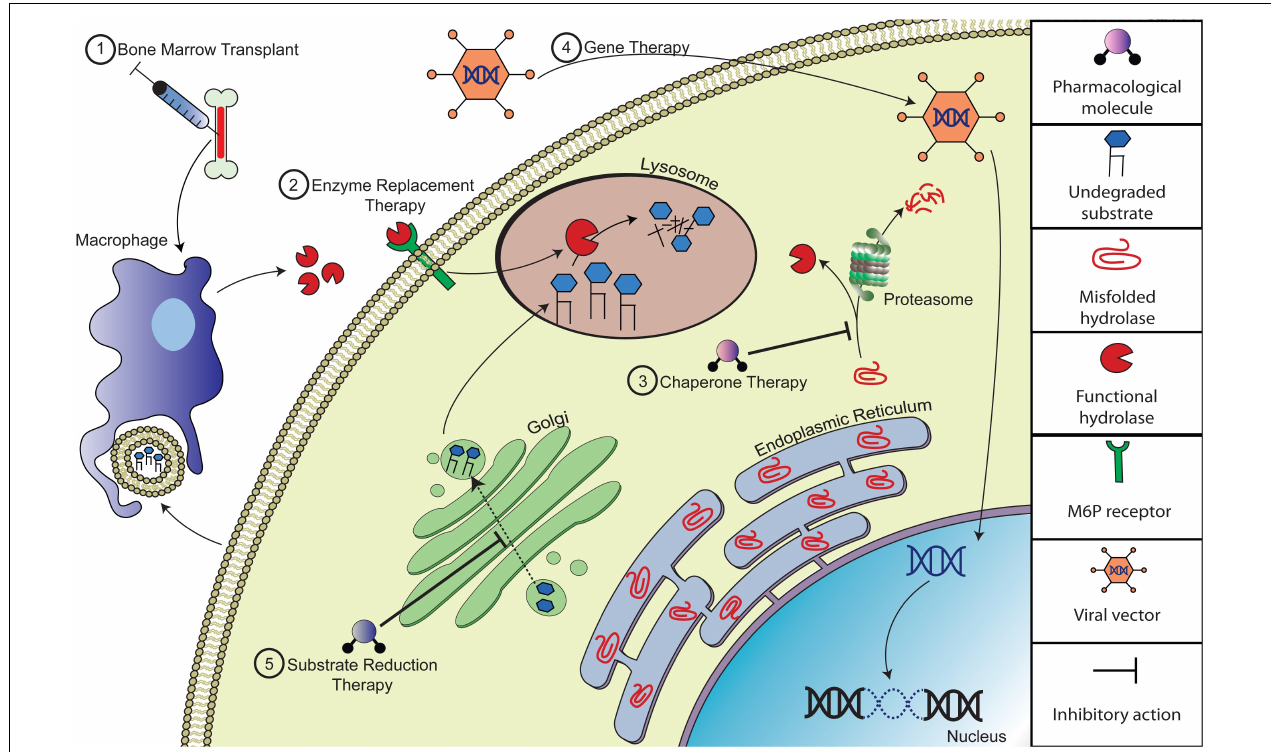
FIGURE 1 | Depiction of potential therapeutic approaches to correct substrate accumulation of lysosomal storage diseases. (1) Bone marrow transplantation (BMT) alleviates storage by introducing normal donor-derived macrophages that will cross-correct with viable lysosomal hydrolases and/or phagocytize excess substrate. (2) Enzyme replacement therapy (ERT) compensates for the loss of endogenous hydrolase activity by providing recombinant enzyme, which could be taken up by mannose/M6P receptors on the cell surface. (3) Pharmacologic chaperone therapy (PCT) can improve the catalytic activity of misfolded lysosomal enzyme by promoting folding and acquisition of functional conformation of the nascent mutant peptide and thus evading pre-mature degradation. (4) Gene therapy (GT) is a therapeutic approach designed to deliver recombinant DNA to enzyme deficient cells, often via viral vector therapy. (5) Substrate reduction therapy (SRT) involves delivery of small molecule inhibitors that reduce biosynthesis of the specific accumulating